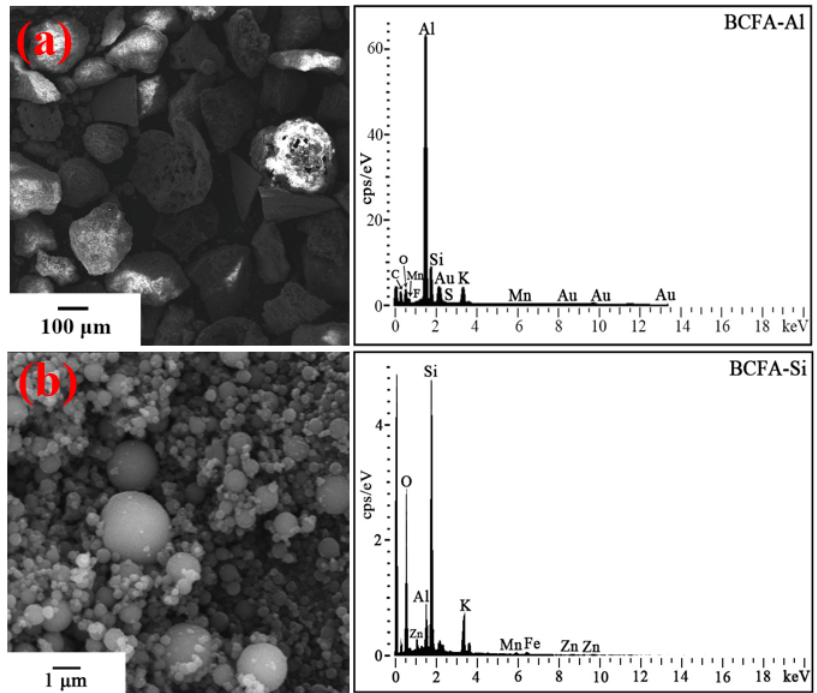
Figure 7. SEM and EDS of BCFA, BCFA-Al and BCFA-Si with wet screening BCDF under 2800 meshes ( a ) BCFA-Al: wet screen products, ( b ) BCFA-Si: vacuum filter residue.